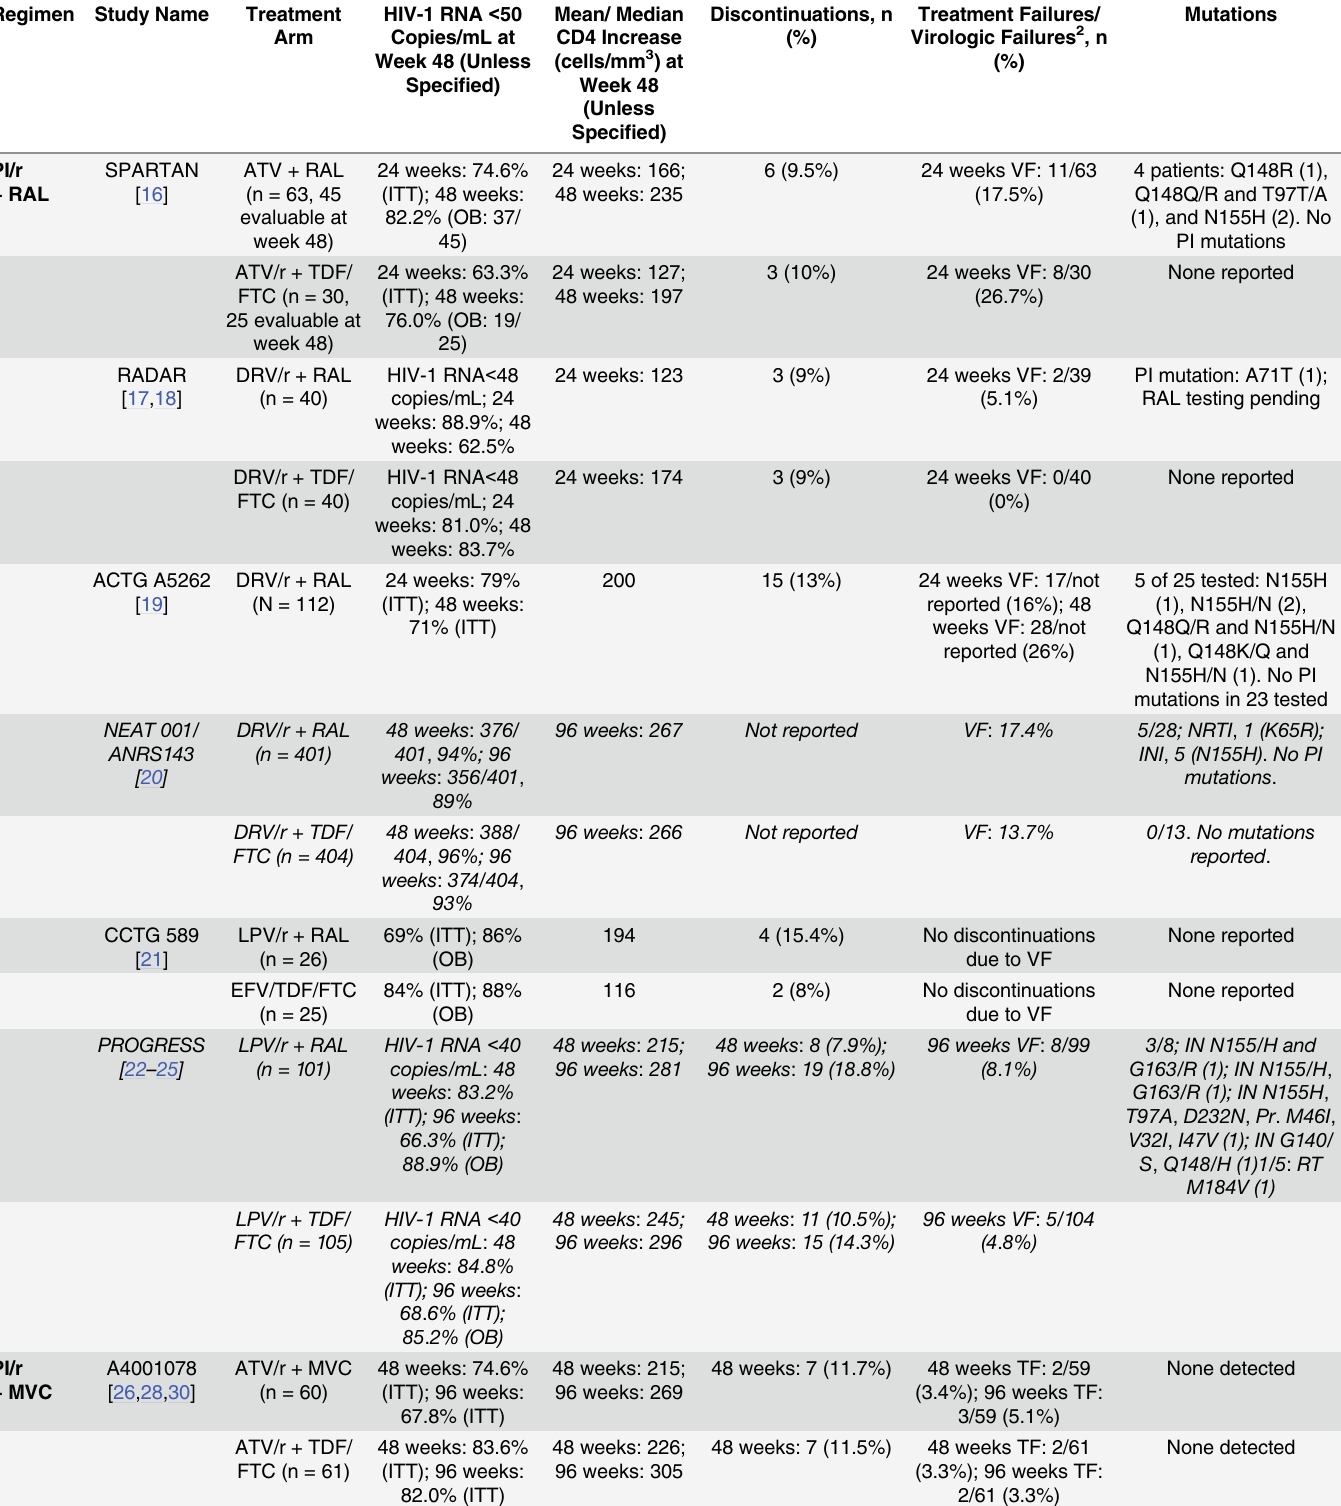
Table 2. Results of key virologic endpoints from identified trials in ARV-naive patients 1